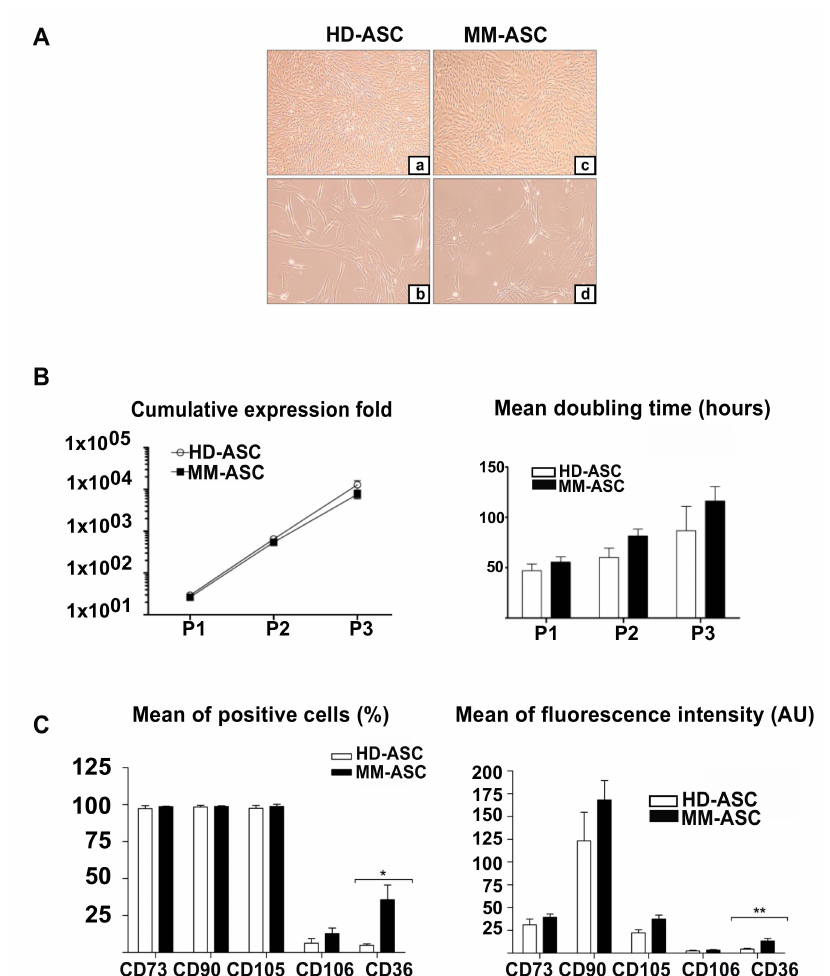
Figure 1. MM-ASC have normal morphology, proliferation capacity, and immunophenotype. ( A ) Morphology of the di ff erent stem cell populations. HD-ASC ( a and b ) and MM-ASC ( c and d ) were visualized at 2 × ( a and c ) or 10 × ( b and d ) magnification, using standard light microscopy. ( B ) Proliferative capacity of HD-ASC ( n = 6) and MM-ASC ( n = 11). Left: Mean cumulative expansion rate between P1 and P3. The number of viable cells (Trypan blue staining) was determined at the end of each passage (at confluence) and the cumulative expansion was calculated as the ratio of the total number of cells collected at the end of the passage to the total number of cells plated. Right: Mean doubling time calculated for each passage as follows: Doubling time = ( ∆ T × ln2) / (ln (Nn) – ln (N0)), where Nn is the number of cells at confluence and N0 is the number of cells seeded. Results are expressed as the mean ± SEM; * p < 0.05, using an unpaired t-test with Welch’s correction. ( C ) Immunophenotypes of HD-ASC ( n = 6) and MM-ASCs ( n = 11) at passage 2. The percentage of positive cells (%) (left) and the mean fluorescence intensity in arbitrary units (AU) (right) are indicated for each hematopoietic marker. Results are expressed as the mean ± SEM, * p < 0.05, MM-ASC vs. HD-ASC using unpaired t -test with Welch’s correction. AU: Arbitrary